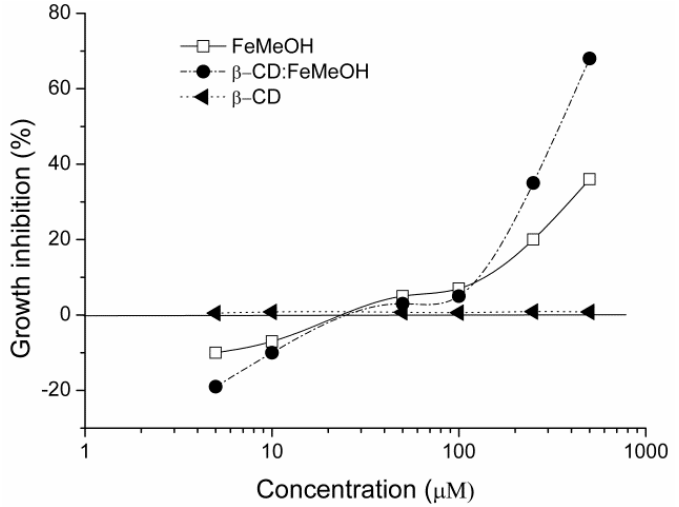
Figure 8. Growth inhibition of the compounds investigated on MDA-MB-231 cell